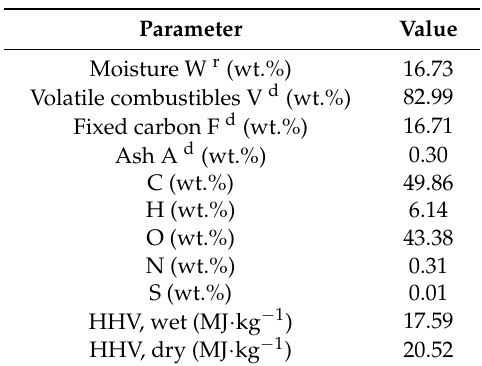
Table 4. Properties of used